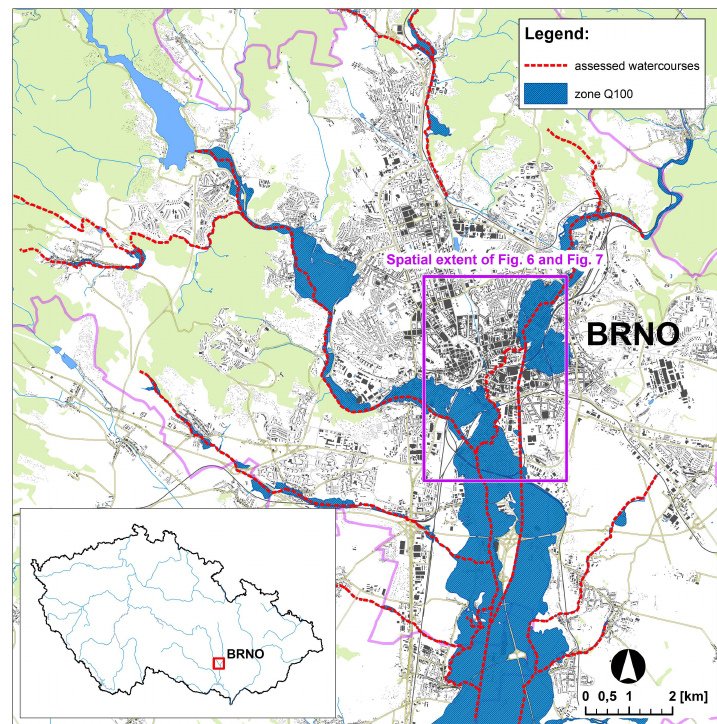
Fig. 5. Layout plan with assessed watercourses in the city of